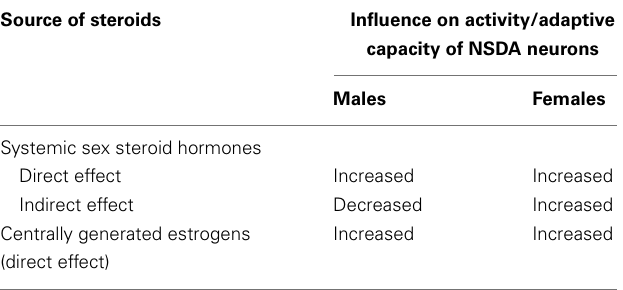
Table 2 | Summary of potential modes of action of peripheral and central sex steroid hormones on the nigrostriatal dopaminergic (NSDA) system in male and female